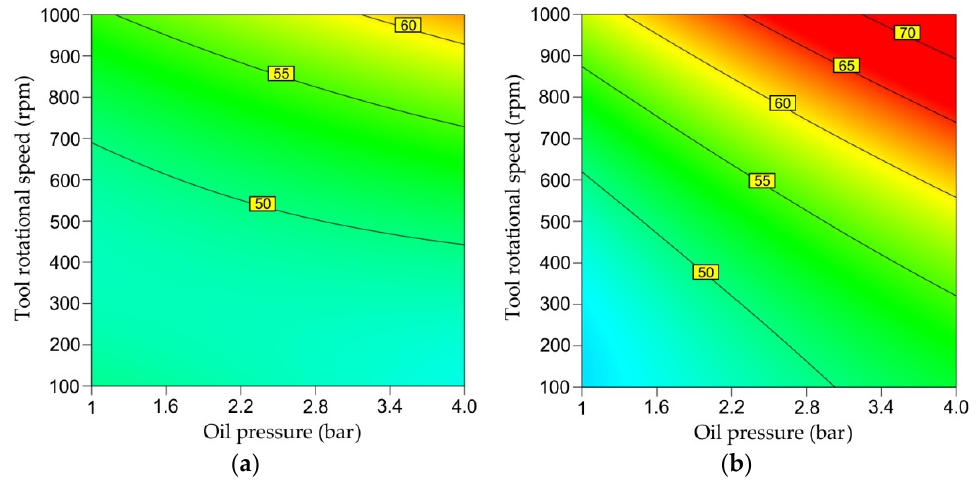
Figure 13. Plots showing the effect of oil pressure and tool rotational speed on maximum formable wall angle α max for ( a ) clockwise and ( b ) anticlockwise direction of tool rotation.